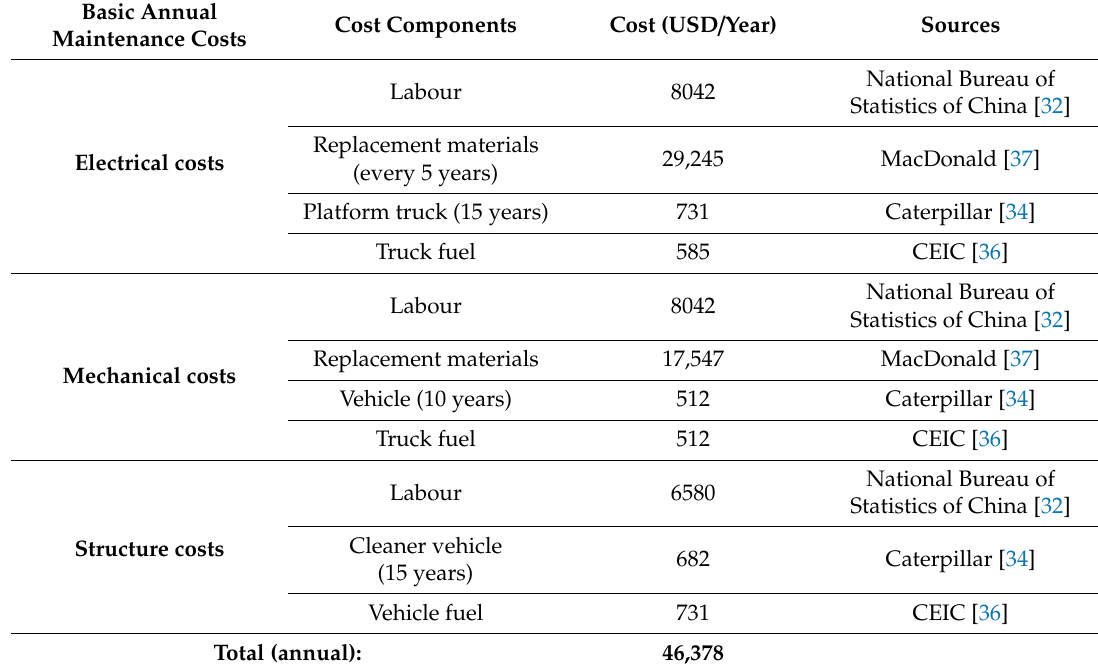
Table 5. Maintenance